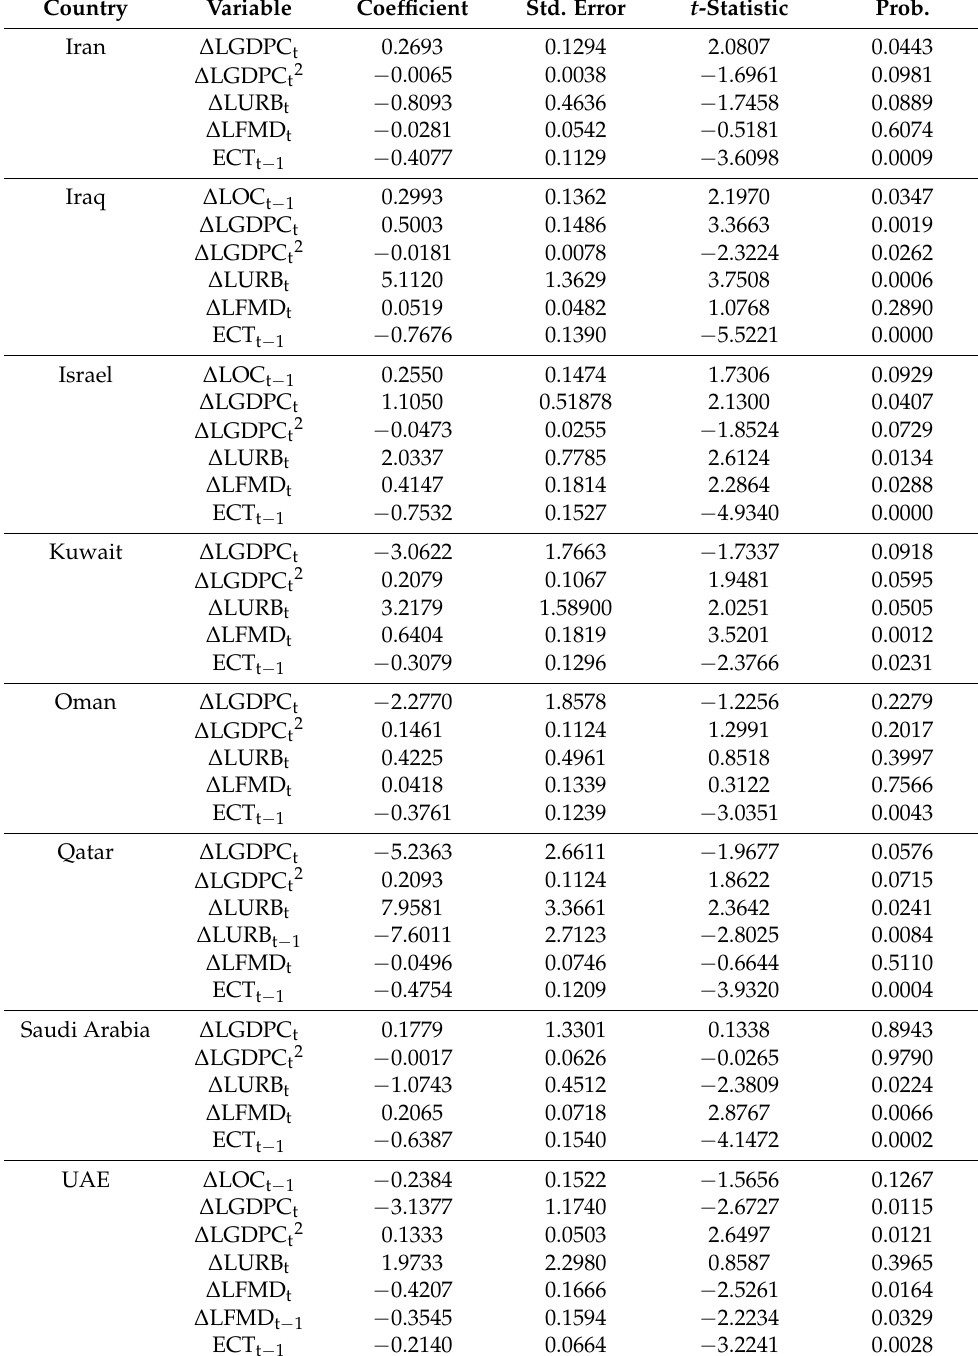
Table 3. Short-run results: ∆ LOC t as the dependent